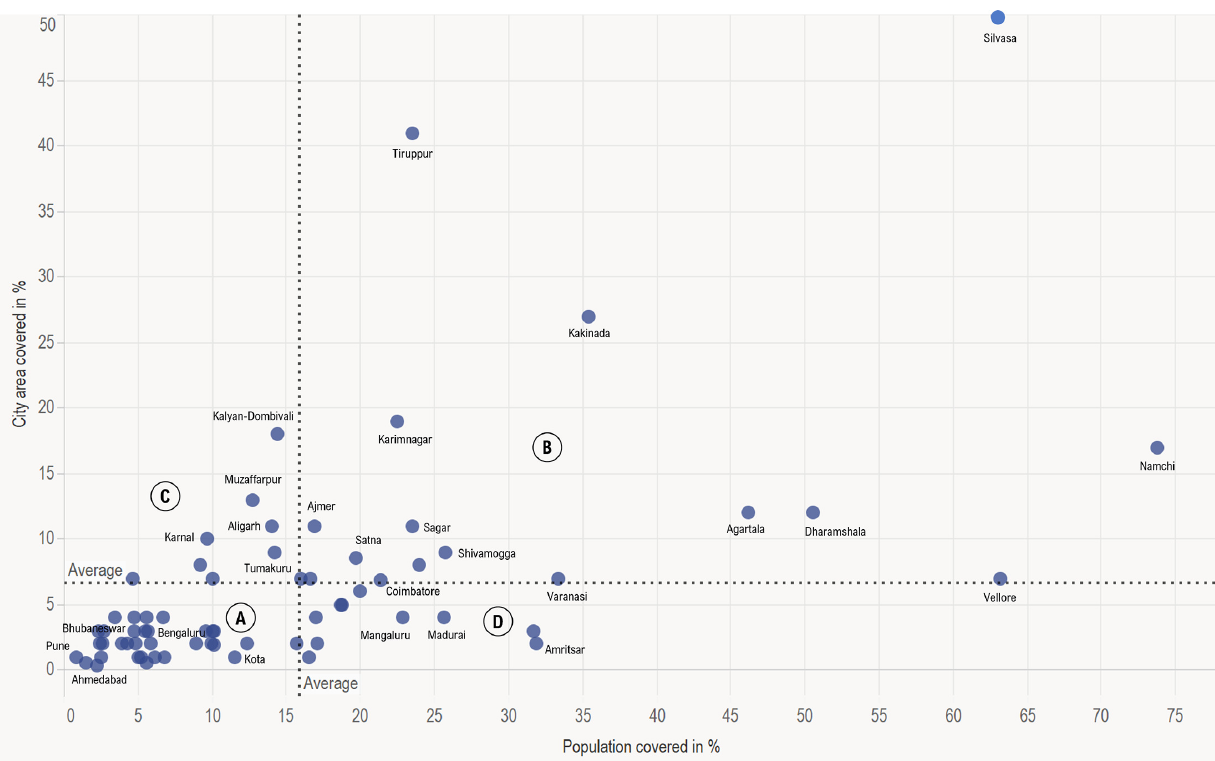
Figure 3. Typologies of cities based on area and population coverage under the ABD projects. Notes: Quadrant A: Low city area and population coverage; Quadrant B: High city area and population coverage; Quadrant C: High city area and low population coverage; Quadrant D: High population and low city area